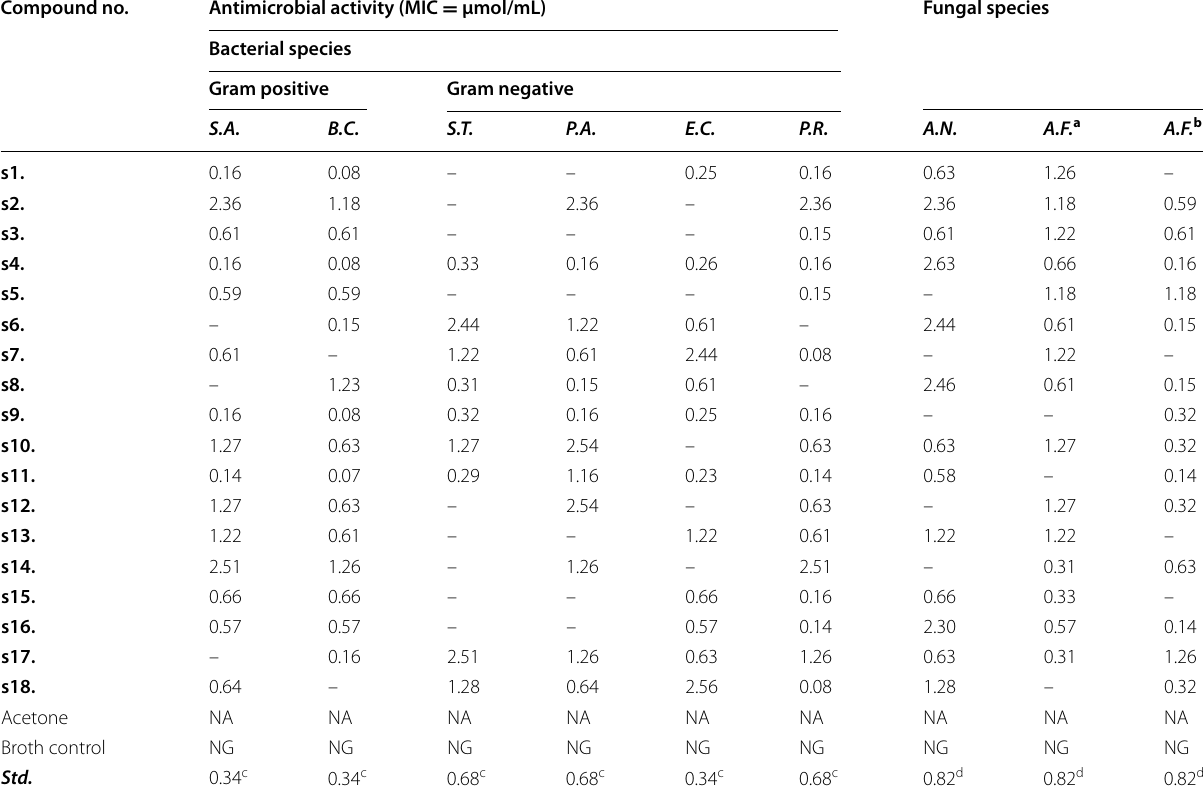
Table 2 Antimicrobial activity results of synthesized bis-pyrimidine molecules